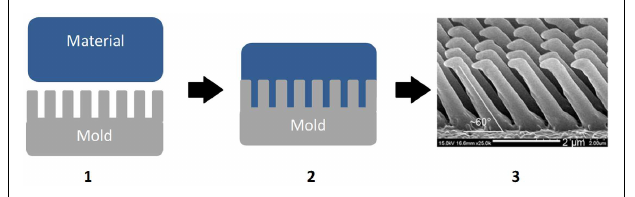
FIGURE 3 |The nanocasting process for synthetic dry adhesive preparation: (1) mold and material preparation, (2) mold infusion, and (3) demolded dry adhesive . From Jeong et al. (2009).